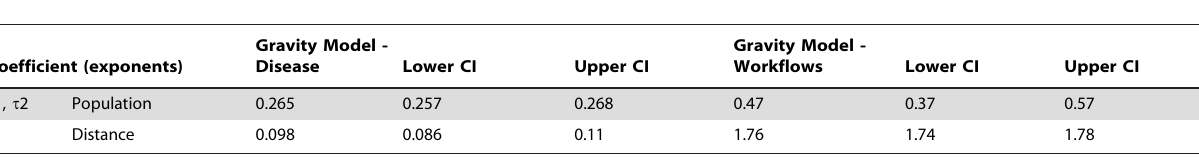
Table 3. Parameter estimates for gravity models (disease spreads and workflows) and the corresponding 95% confidence intervals